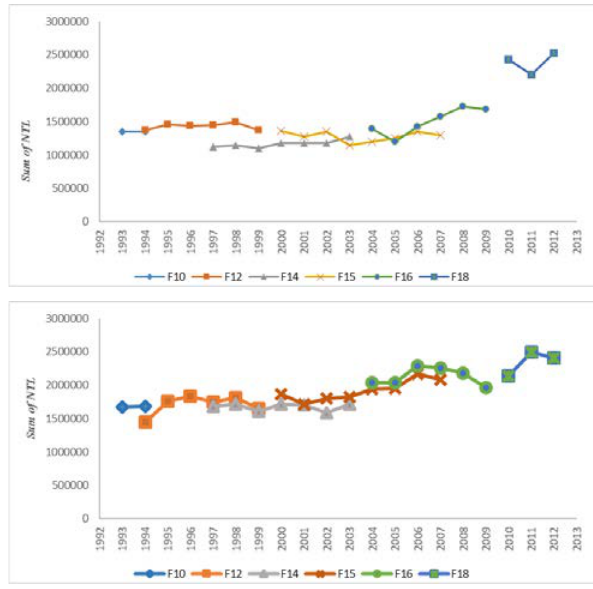
Figure 4. Inter-calibration sum of NTL, in Algeria 1993 to 2012. a) The original sum of the DNs values from nighttime Light data. b) The sum of the DNs values after inter-annual series correction. And after separation is made between light detected from human settlements and light detected from gas flaring in order to allow us to study human settlements without other light emissions and then assess the suitability of using DMSP data in southern Algeria and its ability to monitor gas flaring in the oil- extracting and natural gas provinces. The DMSP can help in national data set of gas flaring volumes reported and data from individual flares. (Elvidge et al., 2009). The objective of the separation between the sum of light values from